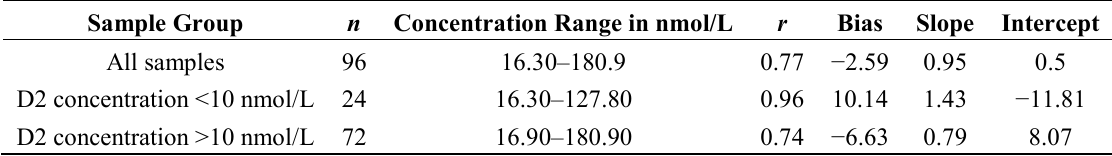
Table 1. Person correlation, bias as calculated by Bland—Altman comparison, slope and intercept according to Deming regression for all samples, samples with D2 concentration less and more than 10 nmol/L as determined by HPLC.